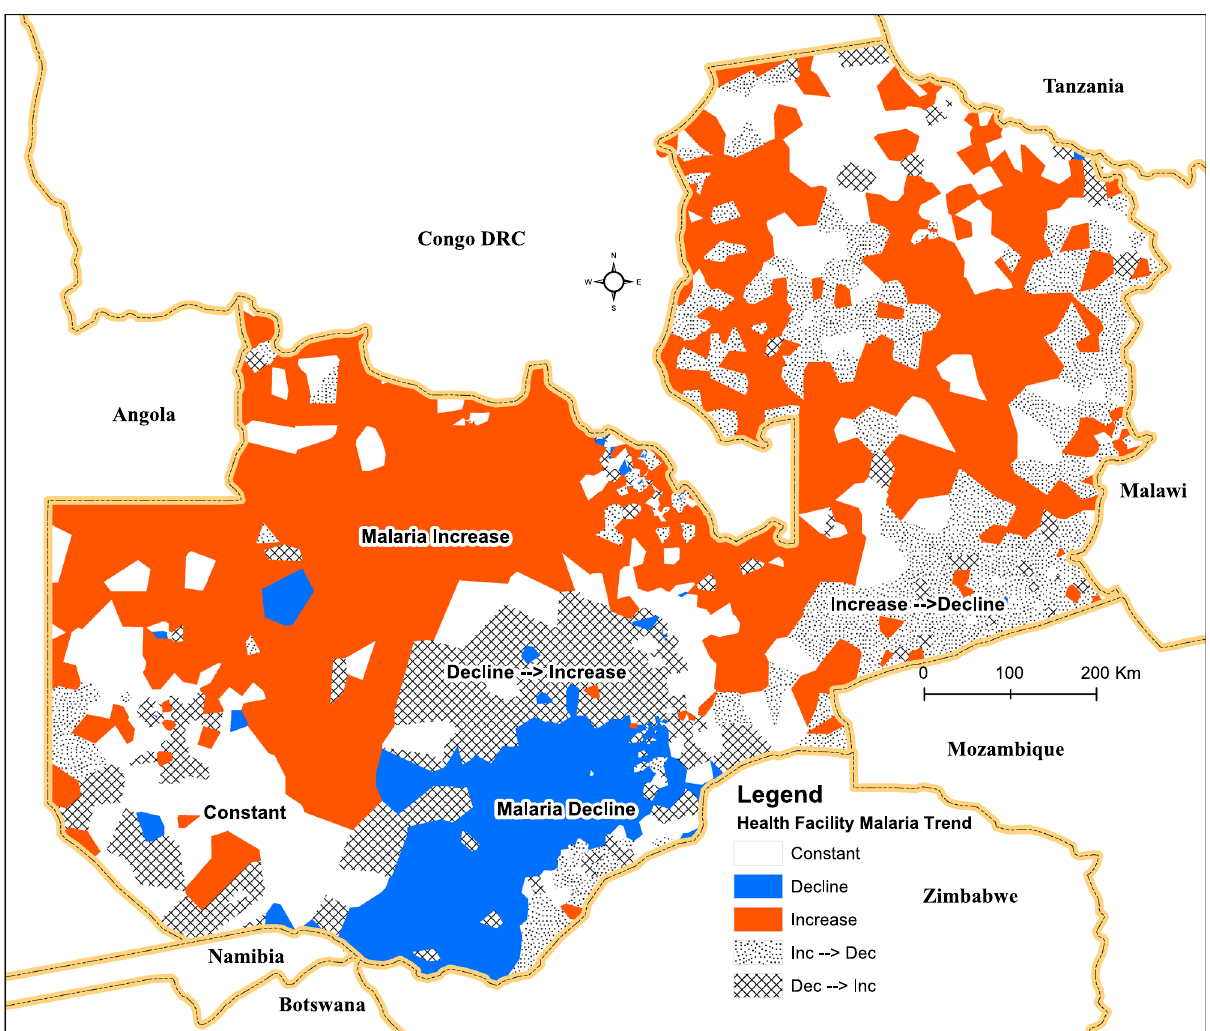
Fig. 7 Health facility malaria incidence trends between 2009 – 2015 (95% credible interval). Colours indicate different temporal trends of areas: Orange shades — areas with continuous increasing malaria trend; blue shades — clusters of areas with declining trends; hatches — areas with a trend changing from declining to increasing after a change point; interlaced black dots — areas with trends changing from increasing to declining; and plain white — areas where no statistically signi fi cant linear trend is